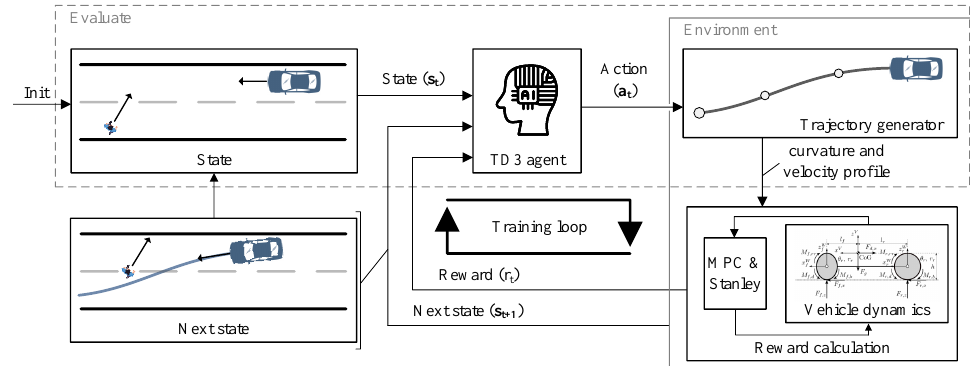
Figure 2. Training